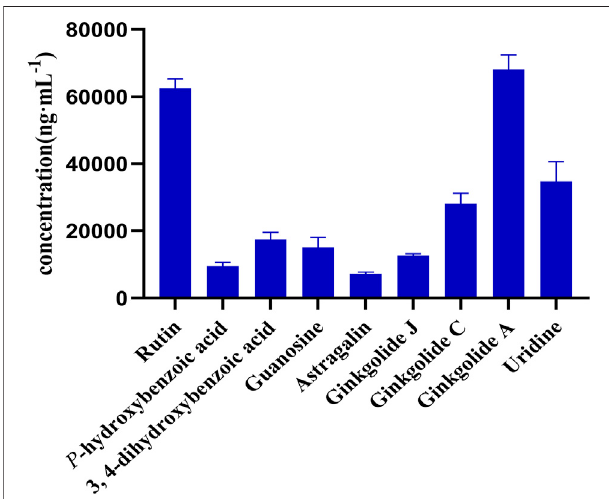
FIGURE 2 | Content of nine compounds in 13 batches of